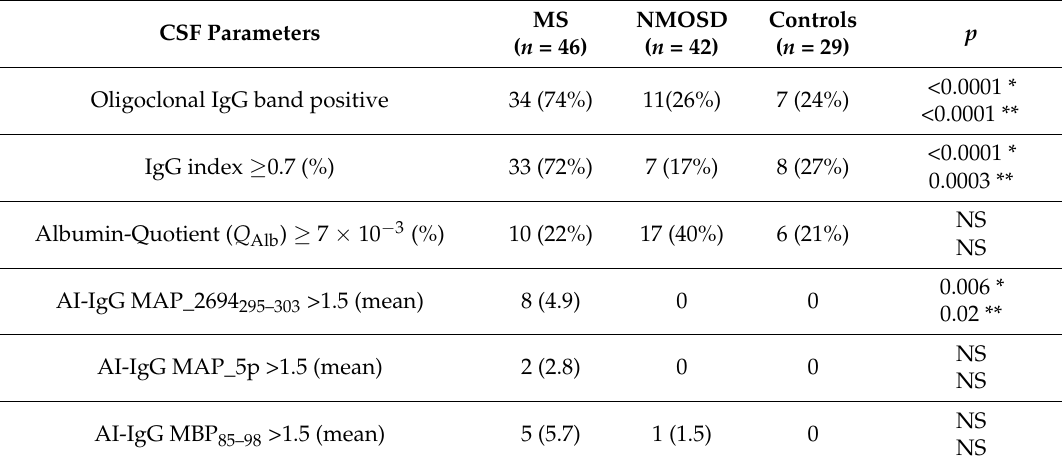
Table 1. Cerebrospinal fluid (CSF)